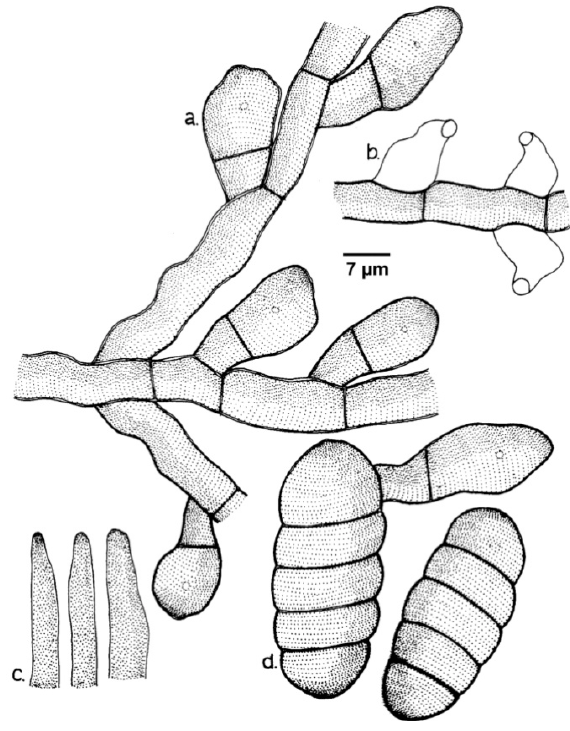
Figure-82. Meliola ichnocarpi-volubili a - Appressorium; b - Phialide; c - Apical portion of mycelial setae; d - Ascospores